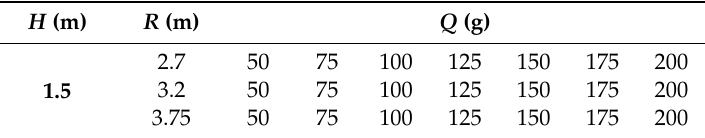
Table 2. Experimental scheme.